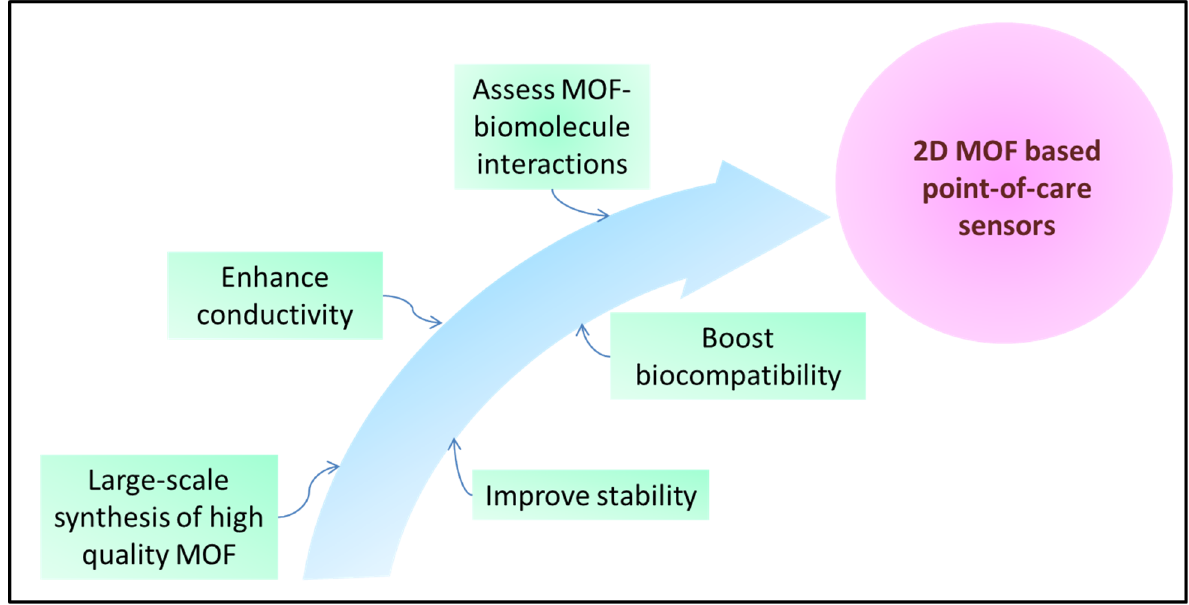
Figure 18. Future perspectives for the development of 2D MOFs as point ‐ of ‐ care sensors.